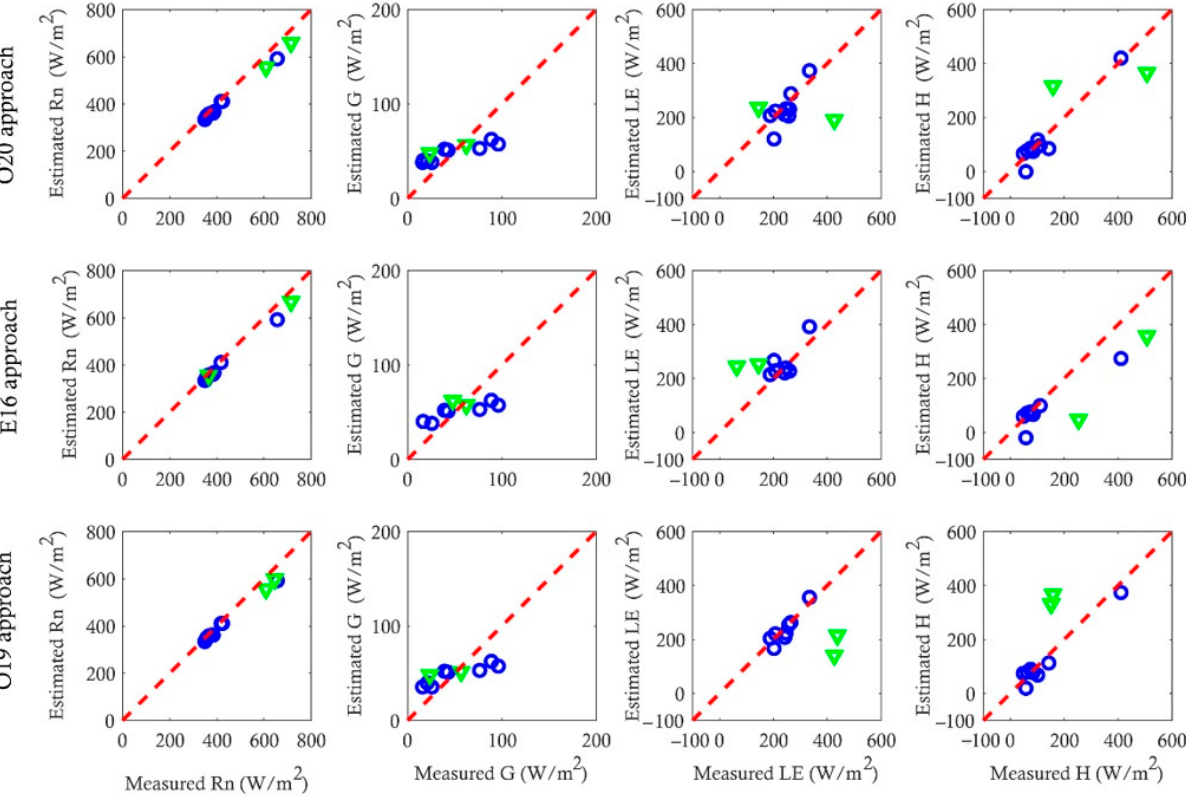
Figure 6. Scatterplot of simulated versus observed Rn, G, LE, and H using the three SM retrieval approaches at the Chichaoua site (green points correspond to anomaly conditions).